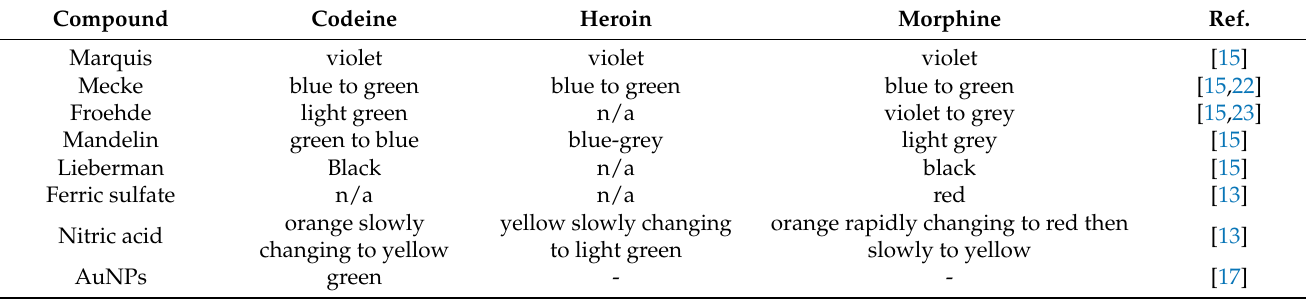
Table 1. Color responses of different chromogenic reagents for detecting codeine, heroin, and morphine. Compound